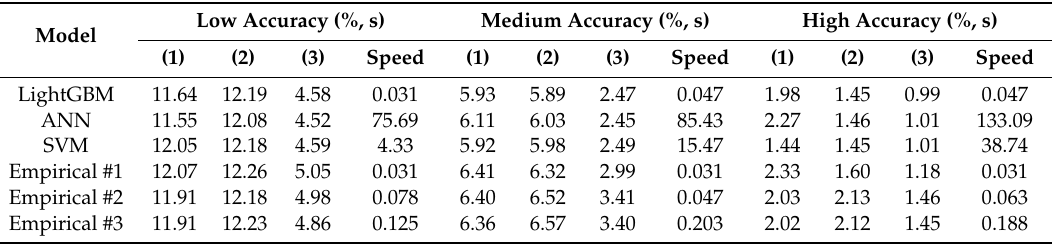
Table 3. Uncertainty indicators of ML approaches for di ff erent levels of data accuracy, including the normalized root-mean-square-error (nRMSE) of the testing set and the processing time. Features considered: G PoA , T amb , and sun position angles.